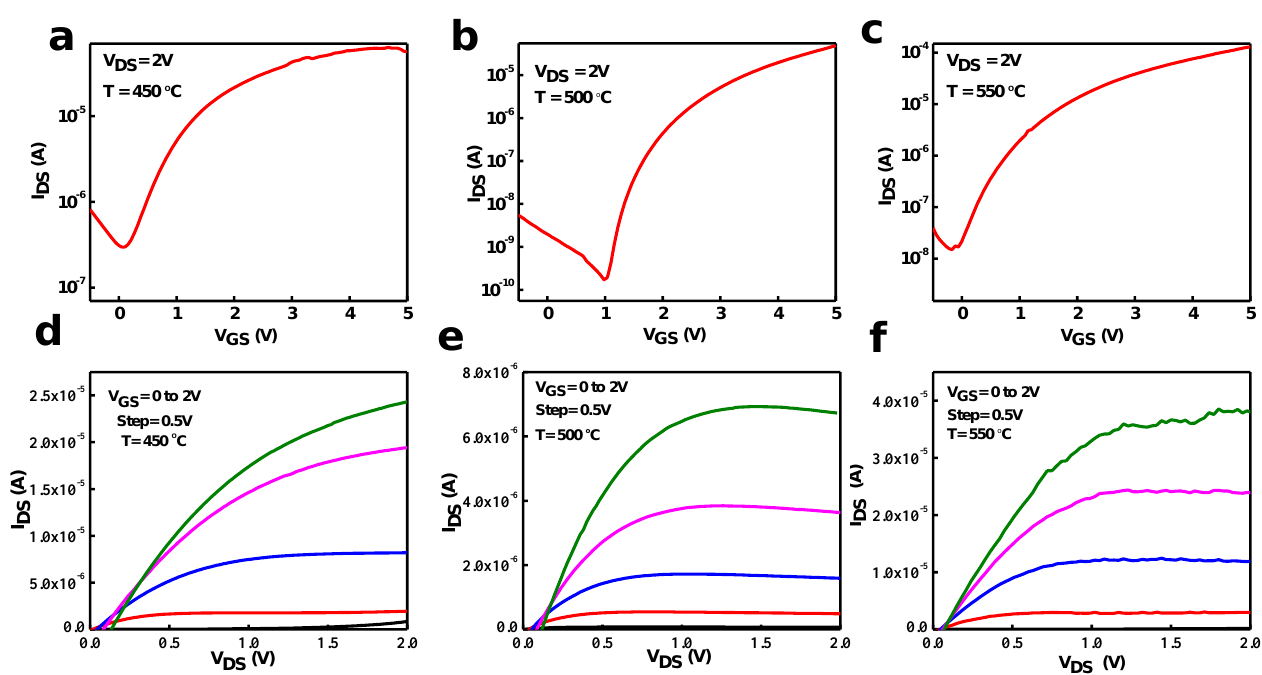
Figure 8. ( a – c ) Transfer characteristics of the In 2 O 3 /HfO 2 TFTs. ( d – f ) Output characteristics of the In 2 O 3 /HfO 2 TFTs.